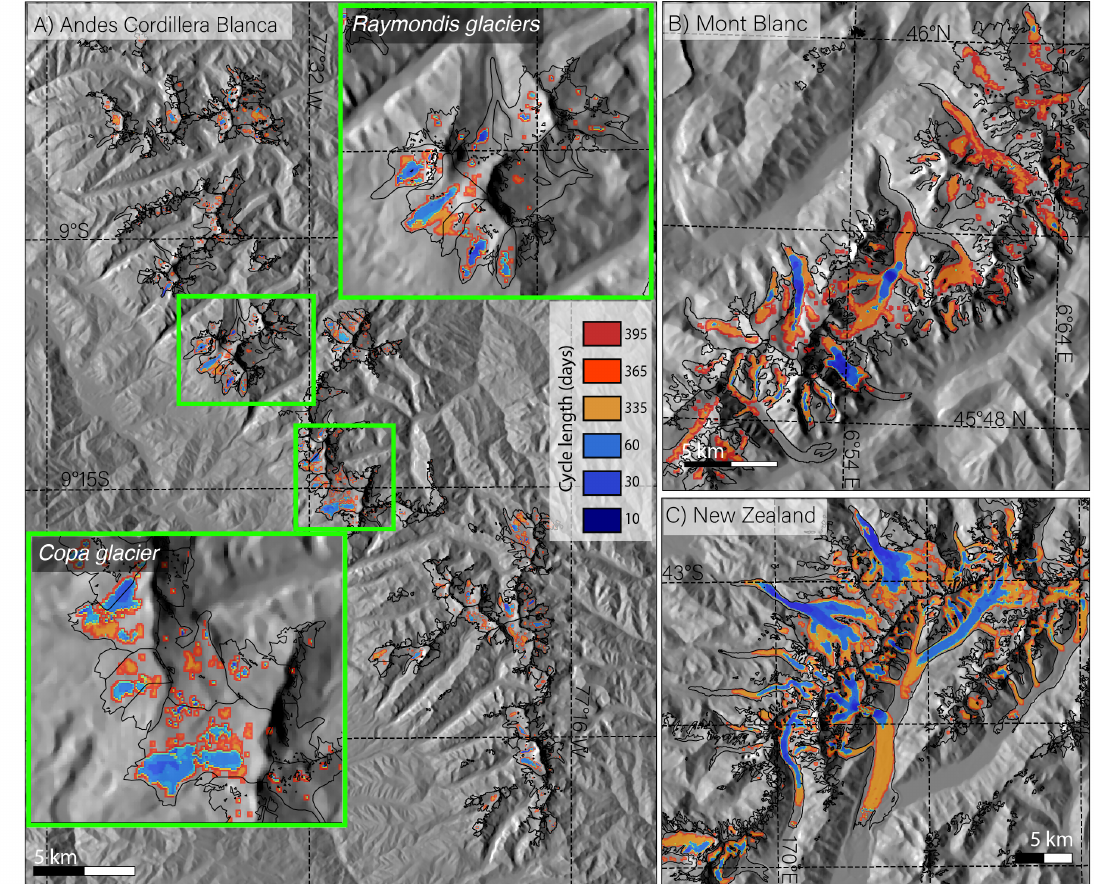
Figure 9. Map of cycle length in days that would be needed to monitor a 10% change in surface velocity with Sentinel-2, for ( A ) the Cordillera Blanca; ( B ) The Mont-Blanc massif in the Alps; and ( C ) the Tasman Glacier region in New Zealand. Note that, when a 10% change in glacier surface velocity is too small to be detected, no color is